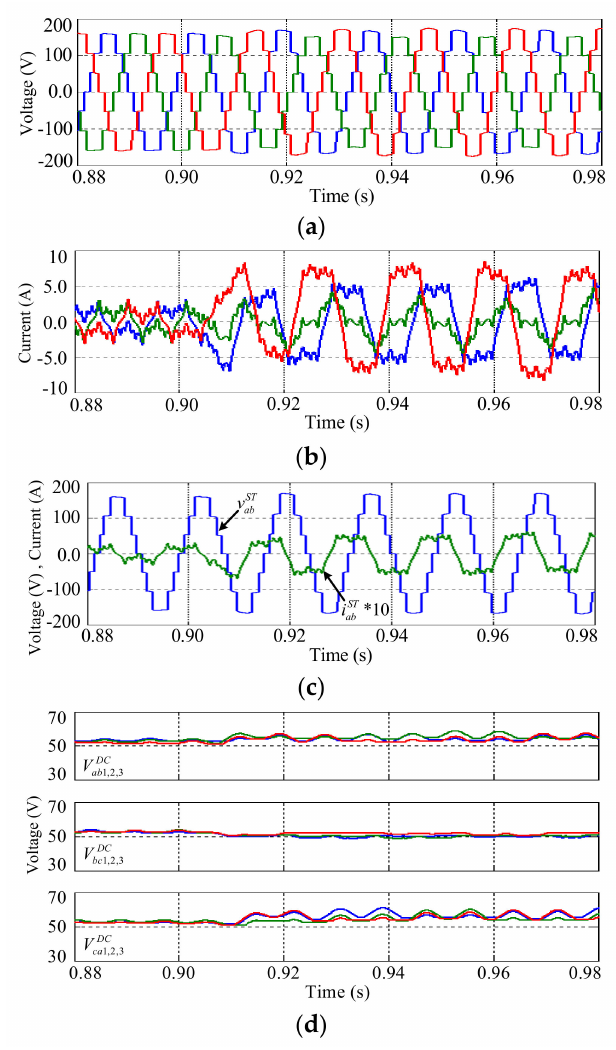
Figure 7. Compensation responses of STATCOM ( a ) STATCOM internal voltage ( v ST current ( i ST ); ( c ) Arm a-b voltage and current ( v ST ab , bc , ca ( V DC , V DC , V DC ca 1,2,3 ab 1,2,3 bc 1,2,3